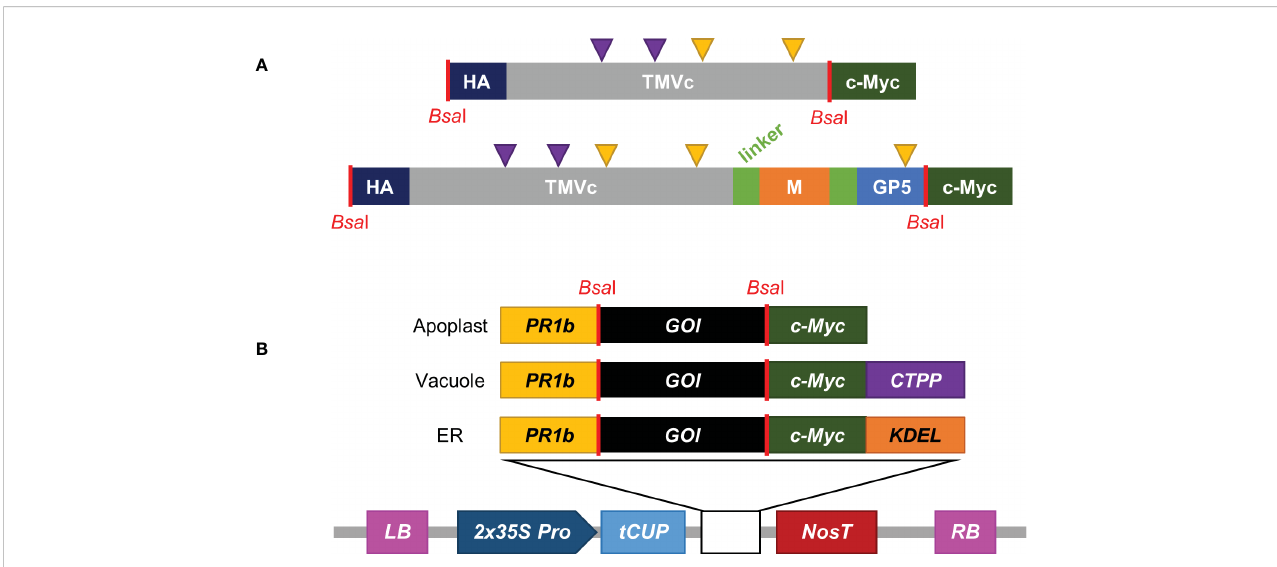
FIGURE 1 Construct design and pCLGG-X plant protein expression vectors. (A) The modi fi ed TMVc monomer is shown in grey, with purple arrows representing the altered amino acids (E50Q and D77N). M (orange), GP5 (light blue) and TMVc are separated by (GGS) 4 fl exible linkers (light green). The C-terminal c-Myc tag (dark green) and the N-terminal HA tag (dark blue) are used for detection. Yellow triangles represent potential sites for N-linked glycosylation. Sequence lengths not to scale. (B) pCLGG-X plant expression vectors target proteins to the apoplast, vacuole, or ER. All three plasmids contain the double-enhanced 35S promoter ( 2x35S Pro ; dark blue), tCUP translation enhancer (light blue) and Nos terminator ( NosT ; dark red) between the left and right T-DNA borders ( LB and RB ; pink). The signal peptides encoded in the gene constructs include the PR1b signal peptide (yellow), the C-terminal propeptide (CTPP) for vacuolar targeting (purple), and KDEL for ER retrieval (orange). GOI indicates the gene of interest. The locations corresponding to Bsa I restriction enzyme sites (red lines) used for GoldenGate cloning are noted in both the protein (A) and nucleotide (B) schematics.